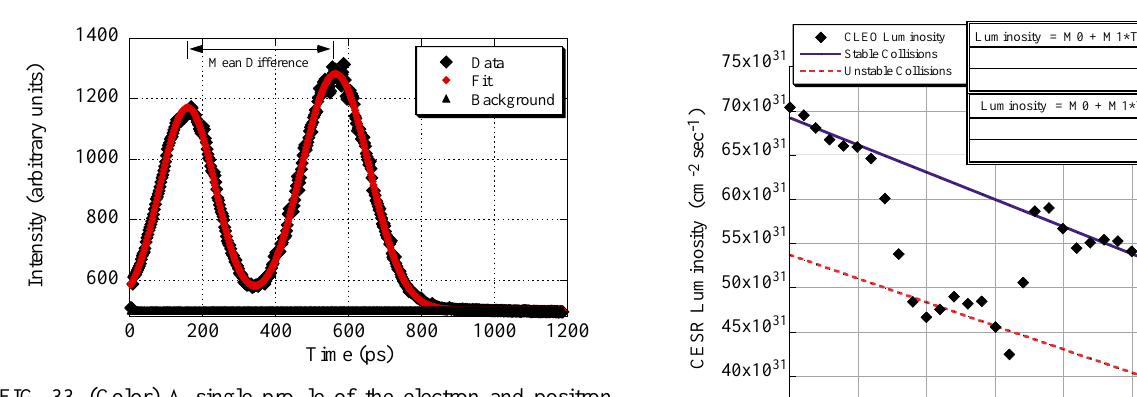
FIG. 33. (Color) A single profile of the electron and positron bunches which collide at the interaction point. The longitudinal distributions are fit and the distance between the distributions is computed.